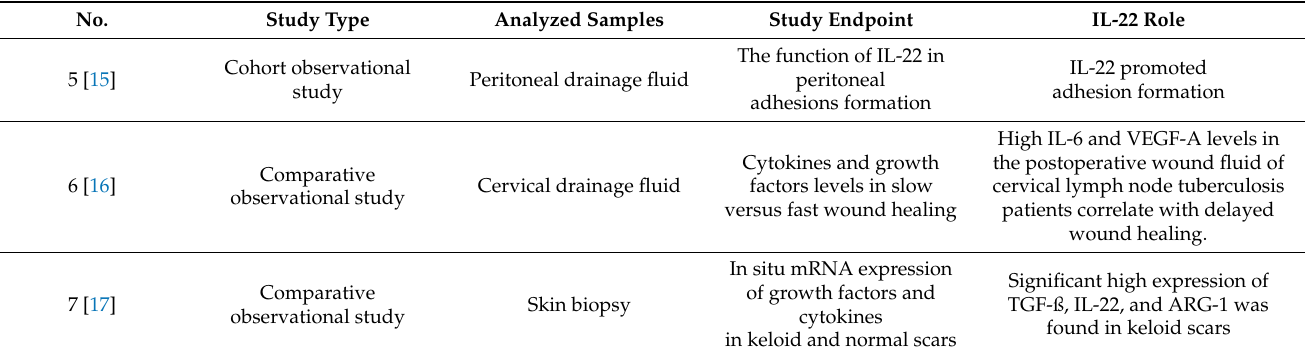
Table 4. Clinical studies included in the systematic